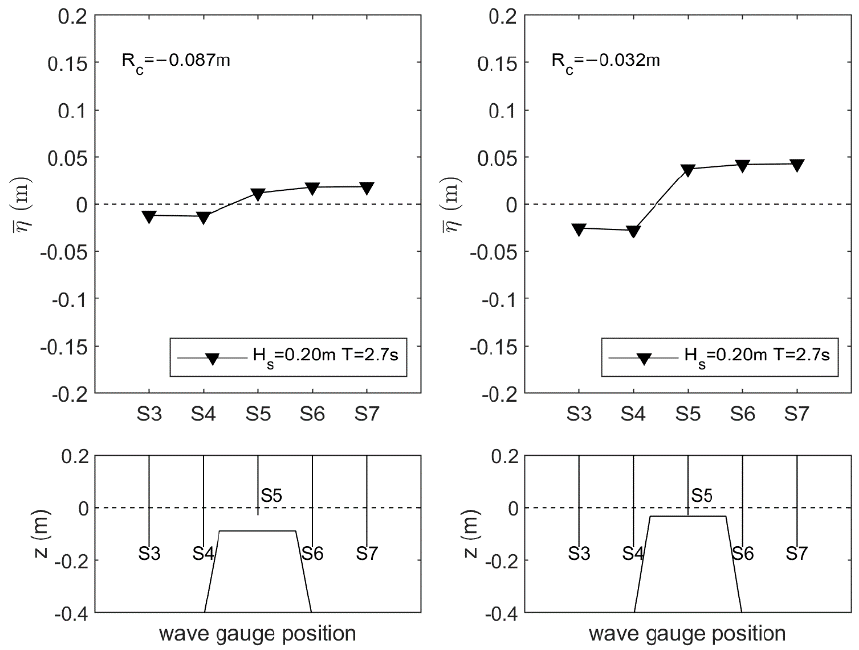
Figure 15. Piling-up behind the submerged breakwater with R c = − 0.087 m ( left panel ) and R c = − 0.032 m ( right panel ) for random waves, with a significant wave height H s = 0.20 m the peak period T p = 2.7s.